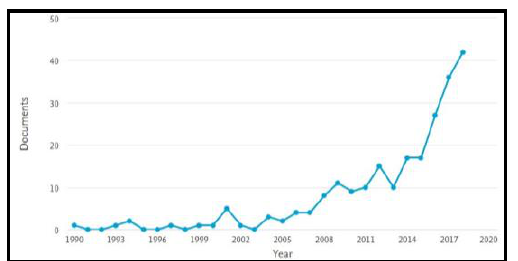
Figure 1: Number of published papers related to water quality and citizen science (Elsevier,